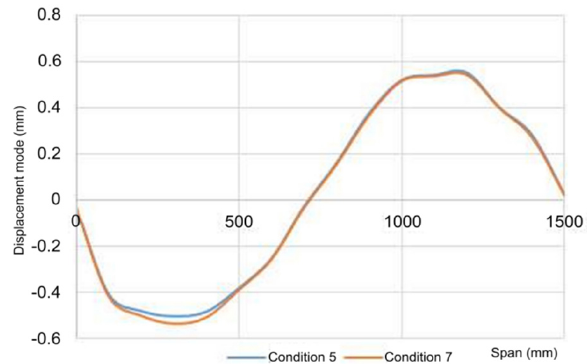
( a ) Comparison of the first-order vibration modes under Conditions 5 and 7.